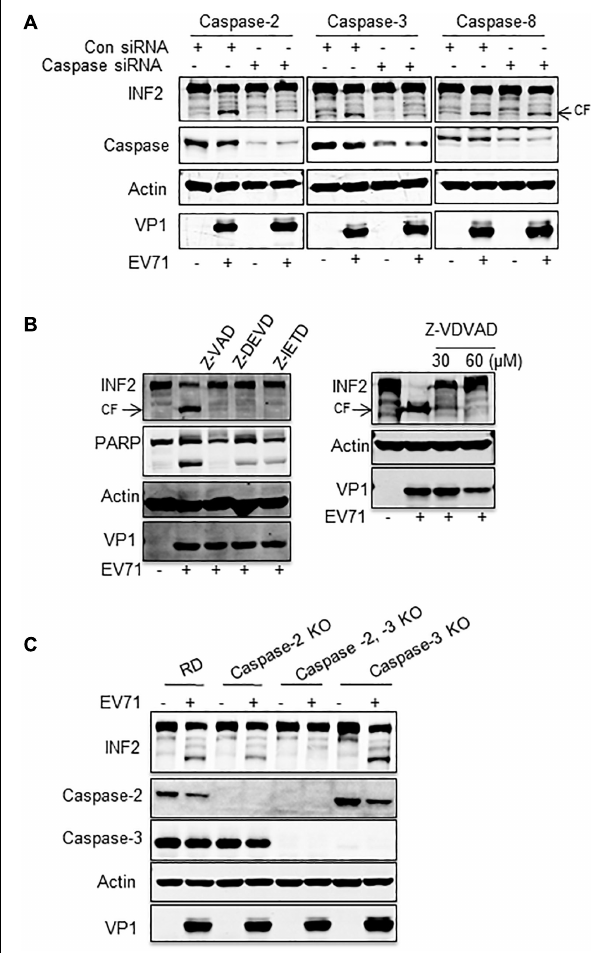
FIGURE 6 | Caspase-2 plays a dominant role in EV71-induced INF2 cleavage. (A) RD cells were transfected with control siRNA or siRNA against caspase-2, -3, and -8, and 36 h after transfection, the cells were mock-infected (EV71-) or infected with EV71 (MOI = 10) for an additional 12 h. Then, the cells were harvested, and a Western blot was performed to detect INF2, the corresponding caspases, actin, and VP1. (B) RD cells were mock-infected (–) or infected with EV71 (MOI = 10) for 12 h, 100 µ M Z-VAD-FMK (Z-VAD, pan-caspase inhibitor), Z-DEVD-FMK (Z-DEVD, caspase-3 inhibitor), Z-IETD-FMK (Z-IETD, caspase-8 inhibitor) (the left panel), and 30 or 60 µ M Z-VDVAD-FMK (Z-VDVAD, caspase-2 inhibitor) were added to the culture media 6 h post-infection. Then, the cells were harvested and lysed for Western blot to detect INF2, PARP, Actin, and EV71 VP1. PARP was used as an indicator of caspase activation and the effect of caspase inhibitors. Arrows indicate the cleavage fragments (CF). (C) RD cells, caspase-2 knockout (KO) cells, caspase-2, -3 double KO cells, and caspase-3 KO were infected with EV71 (MOI = 10) for 12 h; then the cells were harvested, and Western